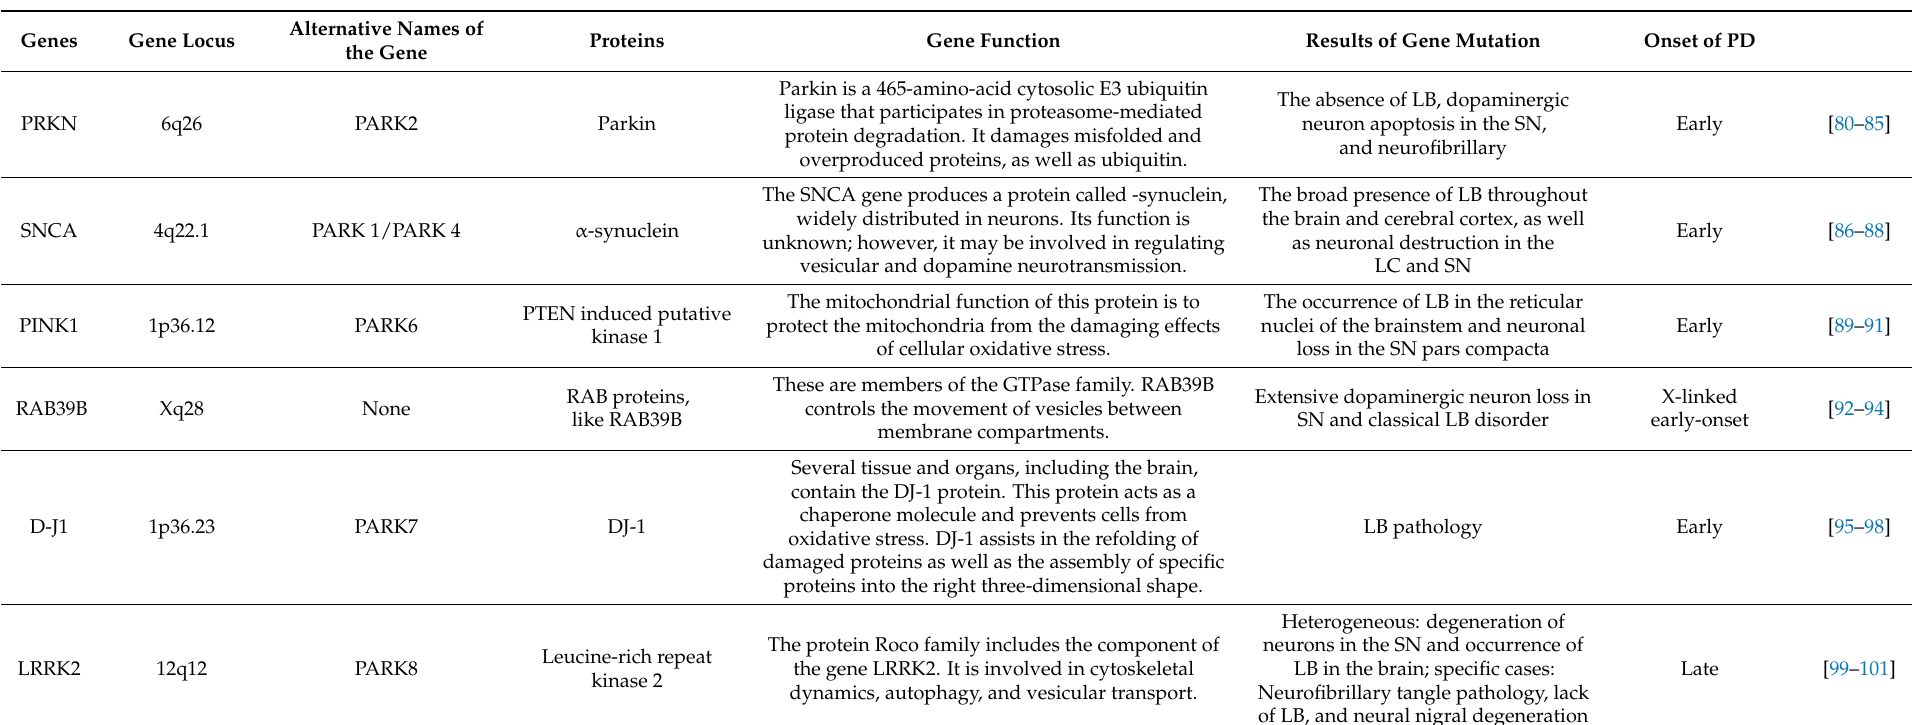
Table 1. Genes implicated in the development of PD, their loci, proteins, functions, phenotypes, and